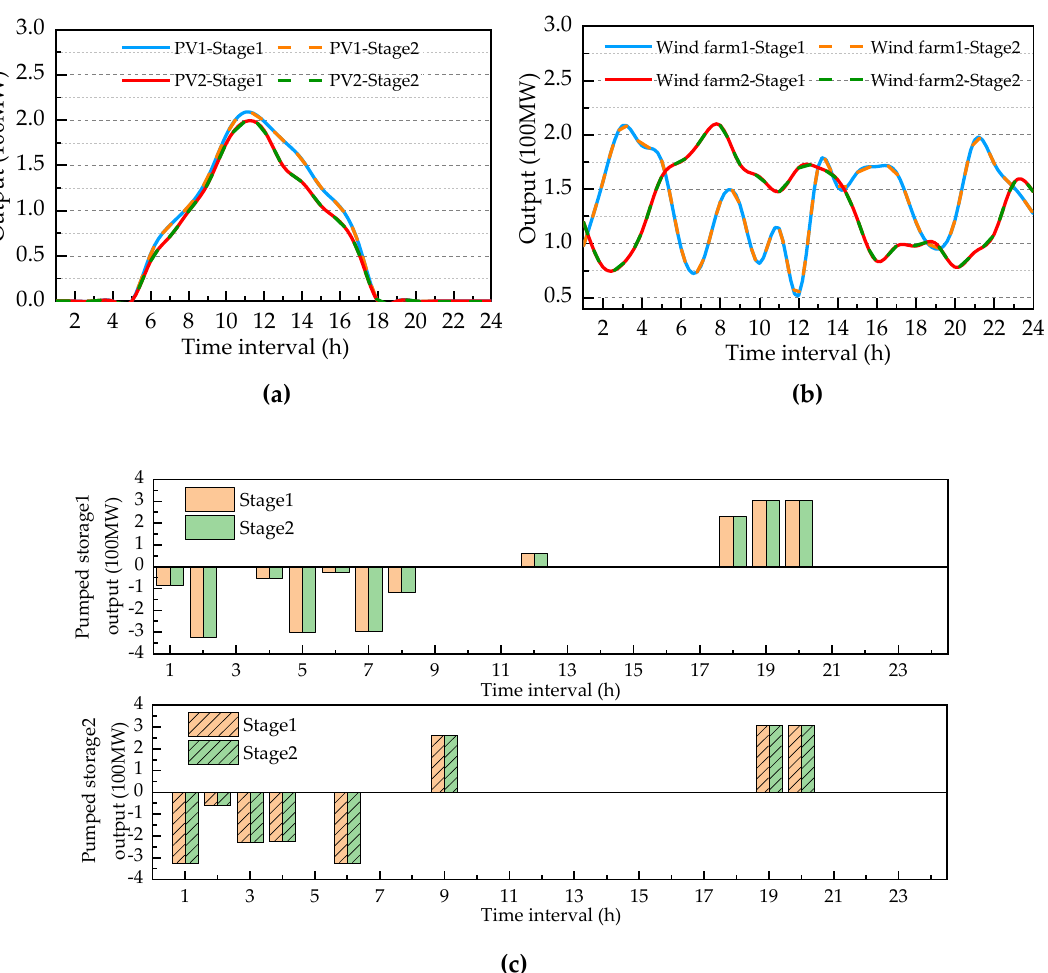
Figure 7. Comparison of outputs of renewable energy units and pumped storage units. ( a ) Comparison of outputs of PV units; ( b ) Comparison of outputs of wind farms; ( c ) Comparison of outputs of pumped storage units.